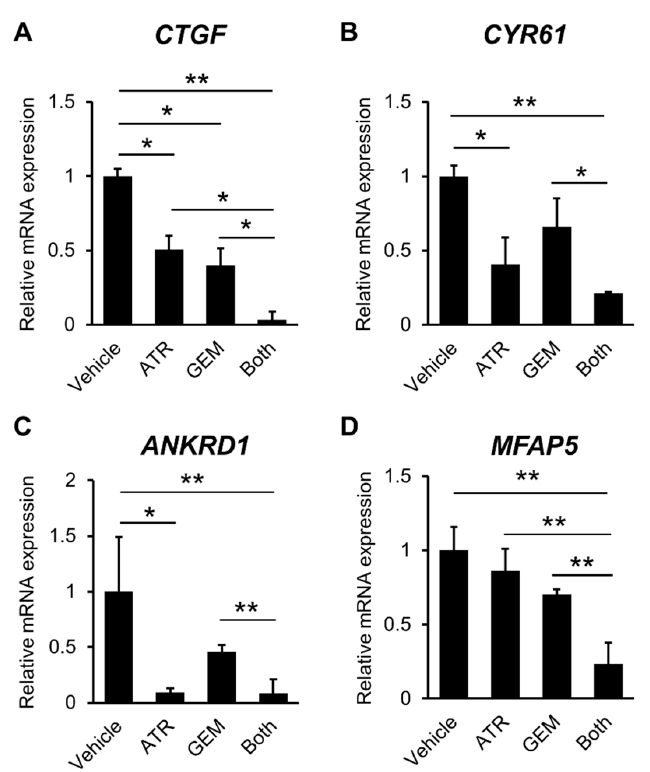
Figure 3. Effects of atorvastatin and gemcitabine on the expression of Yes-associated protein (YAP)/TEA domain (TEAD) target genes in cultured HuCCT-1 cells. ( A – D ) Relative mRNA levels of